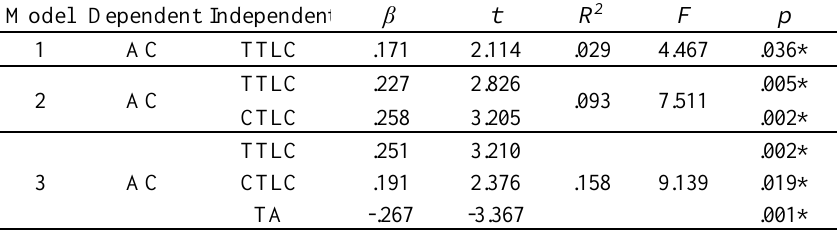
* p < .01 Note. TTLC = Traditional Teaching-Learning Conception; CTLC = Constructivist Teaching-Learning Conception; TA = Test Anxiety; AC = Academic Achievement.